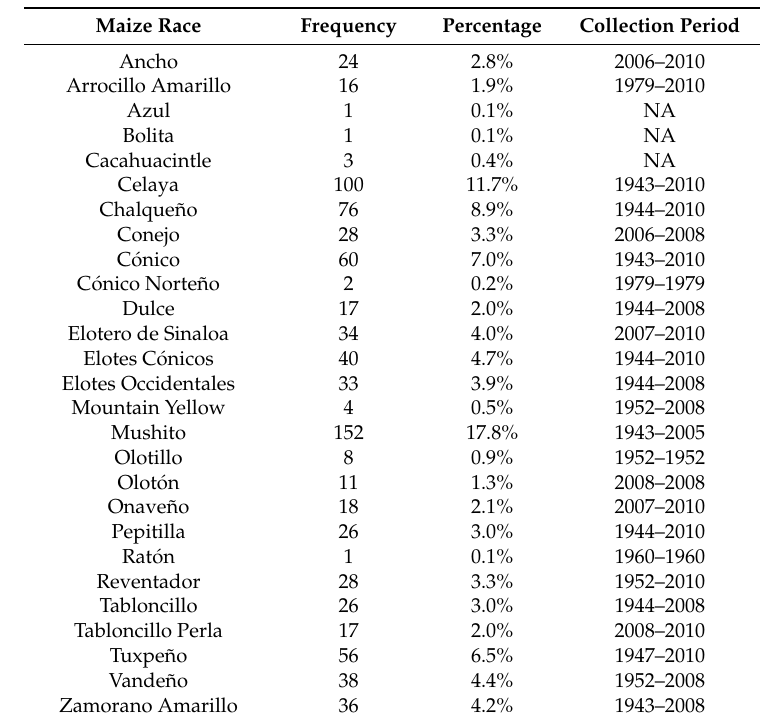
Table 4. Races collected in the state of Michoac á n, percentage, period of collection, location, and main crops substituting planted maize